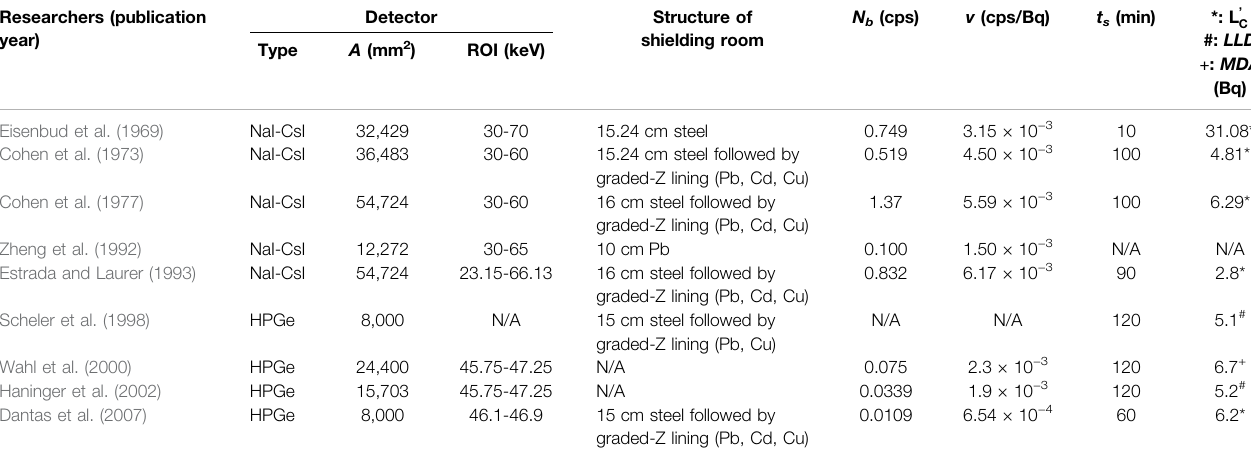
TABLE 1 | Key features from the studies focusing on Pb-210 in vivo measurements. Researchers (publication